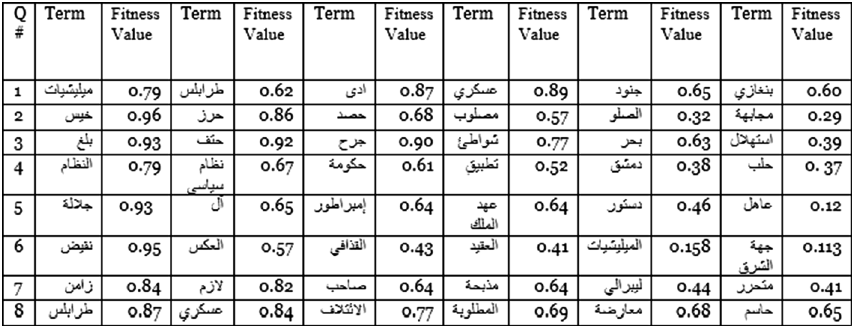
Table 4 Expansion terms and fitness values